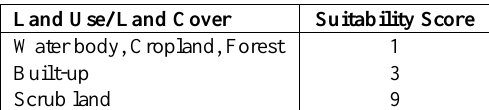
Table 7. Suitability Scores given for different